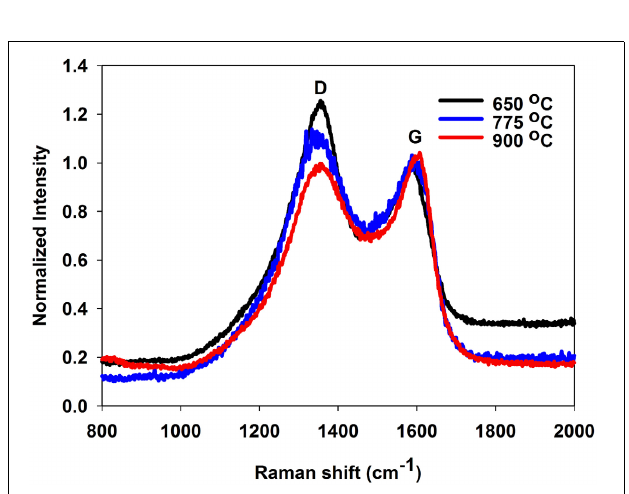
FIGURE 5 | Raman spectrum of sample A2 (TiO 2 @C), demonstrating the drop of D band vs. the G band as the graphitization temperature is